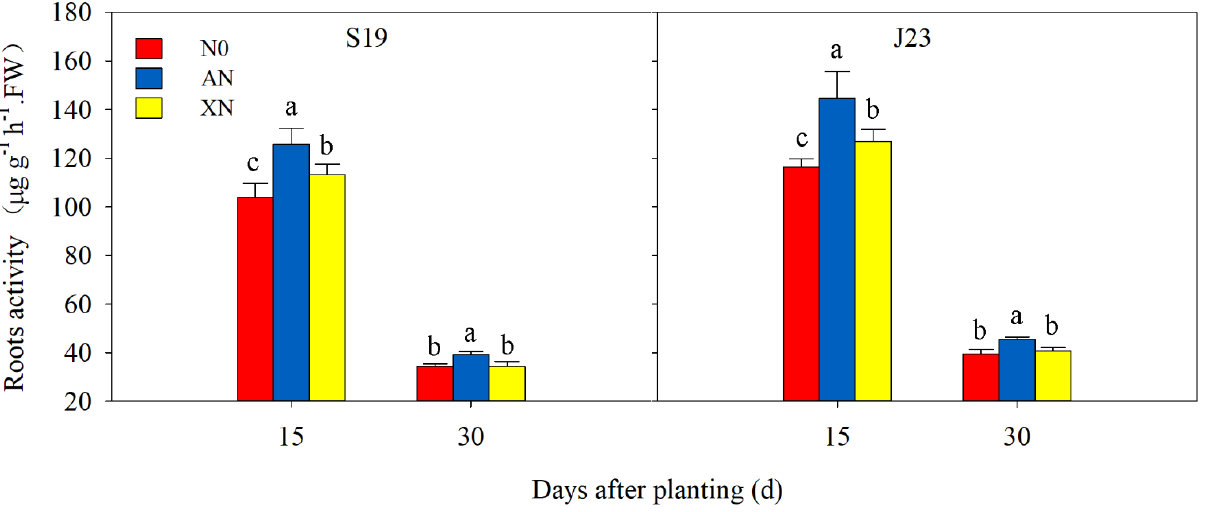
Figure 1. Root activity of sweetpotato at 15 d and 30 d after planting. Note: N0, no nitrogen fertilizer; AN, ammonium nitrogen; XN, amide nitrogen. Error bars represent standard error of the mean (three biological repeats), and different letters (a–c) indicate significant differences between N treatments ( p < 0.05).